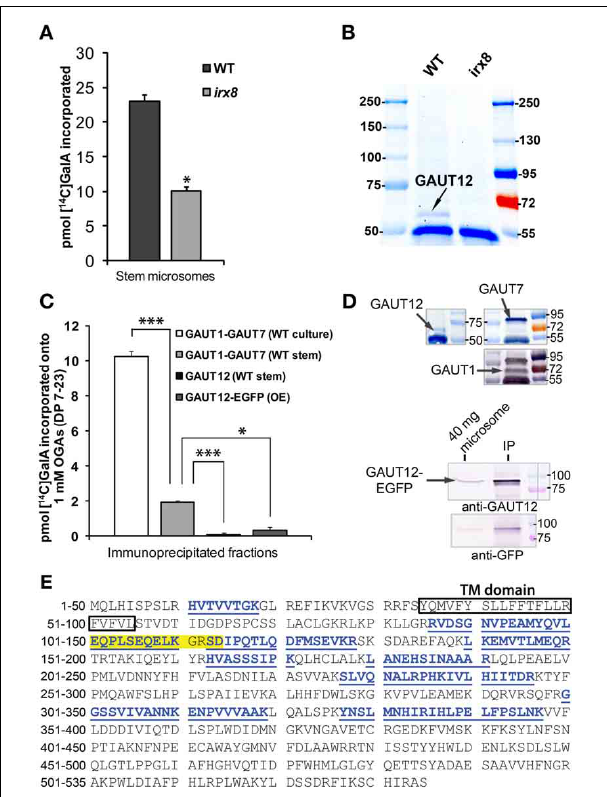
FIGURE 9 | Enzymatic activity assays for GAUT12 and the anti-GAUT12 antibody. (A) HG:GalAT activity of total microsomes (50 μ g) from WT and irx8-5 stems. Value = mean ± standard deviation ( n = 3), ∗ indicates significant reduction of HG:GalAT activity in irx8 stem microsomes at P ( t - test) < 0 . 05. (B) Western blot analysis of immunoprecipitated (IP) GAUT12 fractions from wild-type (WT) and irx8-5 7-week-old stem microsomes (500 μ g total protein) using 30 μ l anti-GAUT12 antibody-conjugated magnetic beads. GAUT12 protein band as indicated ( ∼ 58–60kDa) is present in WT but absent in irx8-5 microsomes. (C) HG:GalAT activity of immunoabsorbed-GAUT12 from WT stem microsomes and from GAUT12-EGFP fusion protein expressed in Arabidopsis suspension culture cells (OE). Immunoabsorbed-GAUT1:GAUT7 complex from WT suspension cell cultures and from WT stem microsomes were used as positive controls. Equal amounts of the corresponding antibody-conjugated beads (30 μ l) were incubated with equal amounts of TX-100 permeabilized microsomes from different tissues (500 μ g total protein). Value = mean ± standard deviation ( n = 3), ∗ , ∗∗∗ indicates significant reduction of HG:GalAT activity determined by One-Way ANOVA and post-hoc Bonferroni corrected t -test at p < 0 . 05 and p < 0 . 001, respectively. Immunoabsorbed-GAUT12 and GAUT12-EGFP activity are similar to background with P ( t - test) values = 0.44 and 0.22, respectively. All enzyme activity assays were repeated at least twice. One set of representative results is shown. (D) Western blots showing the presence of GAUT12, GAUT1, and GAUT7 in the corresponding immunoabsorbed fractions from WT stem tissues. GAUT12 was immunoabsorbed by the anti-GAUT12 antibody, and the GAUT1:GAUT7 complex was immunoabsorbed by the anti-GAUT7 antibody. Arabidopsis culture expressed-GAUT12-EGFP ( ∼ 86KDa) fusion protein in the anti-GAUT12 immunoabsorbed fractions used in reactions in (C) shown in the lower panel. (E) GAUT12 protein sequence (535-a.a.). The antigenic-peptide used to generate the anti-GAUT12 antibody is highlighted in yellow. Peptides identified in GAUT12-IP fractions by LC-MS/MS are labeled in blue with underlines. Boxed sequence indicates the GAUT12 transmembrane (TM) domain predicted by